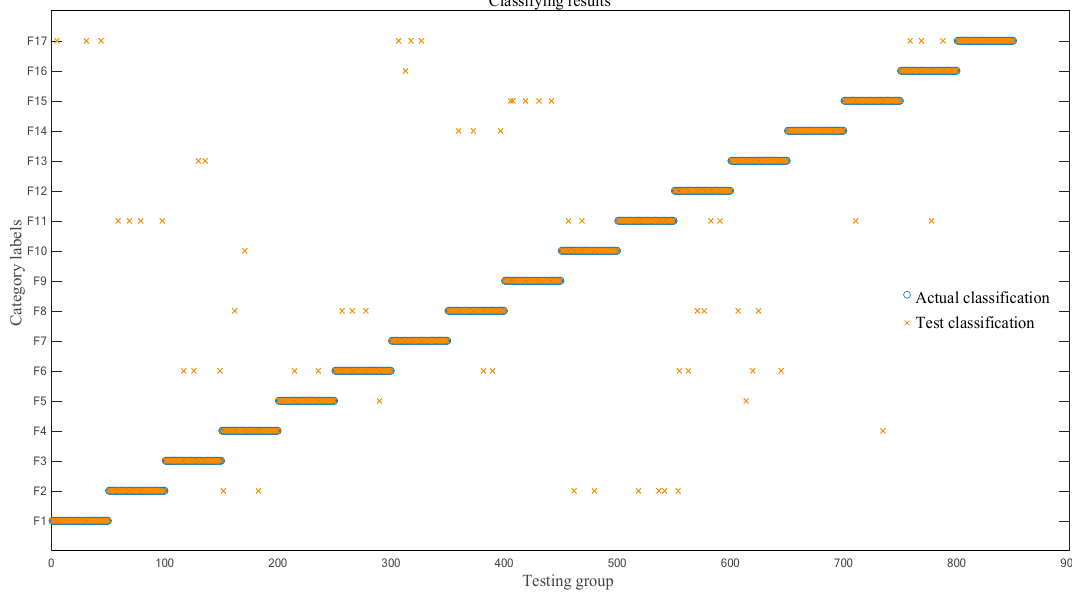
Figure 9. The results of the classification with proposed method.